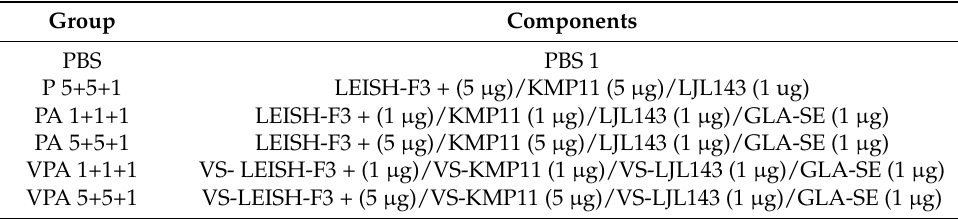
Table 1. Experimental vaccination